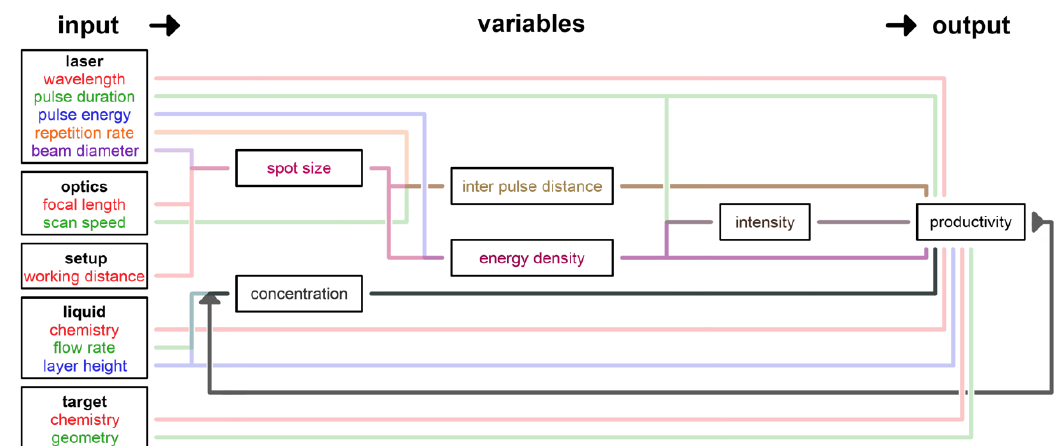
Figure 5. Dependence graph of process parameters, arranged in component clusters, relevant to LAL up-scaling. If not marked differently by an arrow, the flow goes from the left to the right in horizontal direction and from the outside to the inside in vertical direction. Colors were used only for an improved overview. Reprinted with permission from [66].